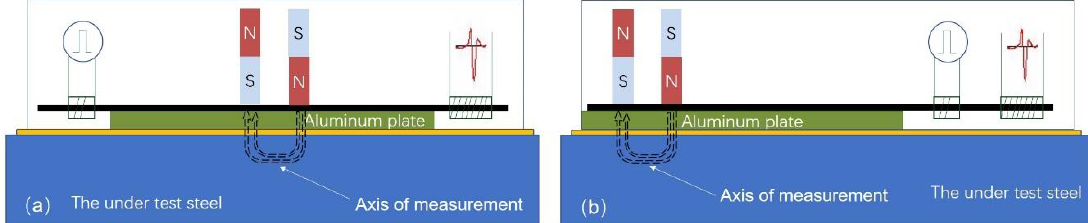
Figure 12. A sensor able to determine the permeability component on the X and Y axes: The magnetic flux between the two permanent magnets is oriented in the main direction; thus, the force exerted on the MDL depends on the permeability along this direction; ( a , b ) show two di ff erent arrangements of the set-up like Figure